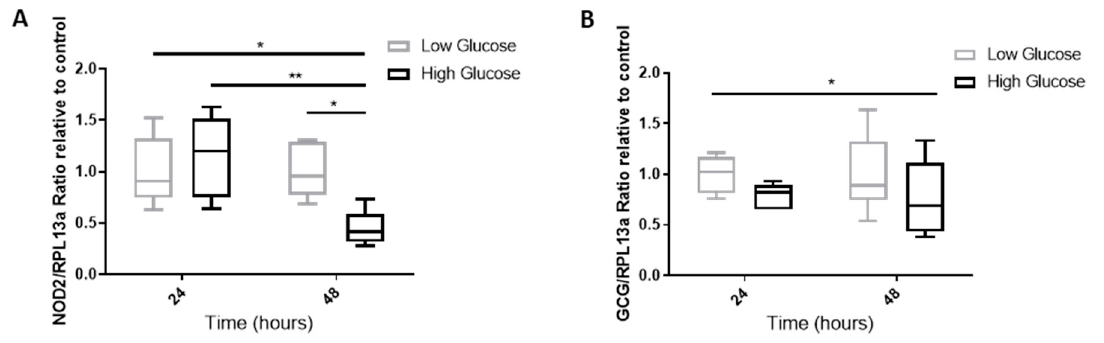
Figure 7. NOD2 and GCG expression are reduced under high glucose conditions. GLUTag cells were incubated for 24 or 48 h in low (5 mM) or high (25 mM) glucose media. Expression for NOD2 ( A ) and GCG ( B ) were examined by RT-qPCR and analyzed using a two-way ANOVA and Sidak post-hoc test. * p < 0.05, ** p < 0.01, n = 6.